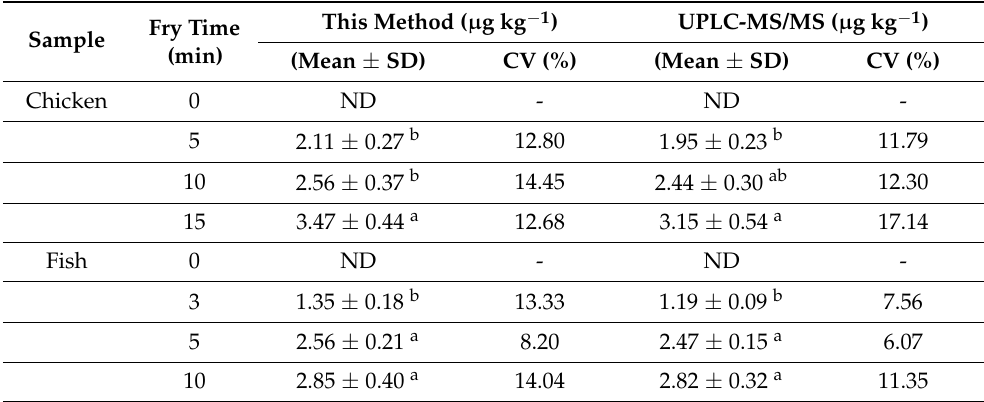
Table 1. Comparison of this method with UPLC-MS/MS for the analysis of 2-amino-3-methylimidazo [4, 5-f] quinoline (IQ) in pan-fried meat patties.